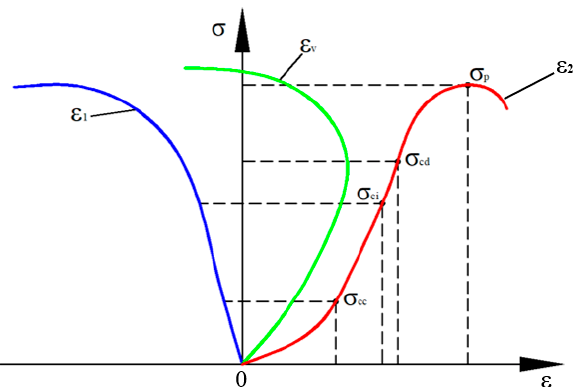
Figure 7. Diagram of characteristic stress corresponding value (Cai et al. [23]). In this paper, the closed stress σ cc , crack initiation stress σ ci , damage stress σ cd and peak strength σ p of rock specimens under different loading rates and confining pressures in triaxial tests, are obtained by using volumetric strain and circumferential strain. Figure 7 is the characteristic stress curve of the specimen. It can be seen from Figure 7 that, with the increase in confining pressure, the characteristic stress increases in varying degrees, indicating that the expansion of rock specimens will require higher stress after the confining pressure increases. From another aspect, confining pressure has an inhibitory effect on the expansion of specimens. At high confining pressure, the inflection point of the volumetric strain will be delayed, so the crack initiation stress and damage stress will be increased. It can be seen from the closed stress σ cc in Figure 8a that, under the same confining pressure, the closed stress of mudstone gradually increases with the increase in loading rate, and the closed stress has a good linear relationship with the loading rate. It is found that the closed stress and loading rate of mudstone can be described by a linear relationship: When the confining pressure W is 1 MPa, the loading rate S increases from 0.3 mm/min to 1.8 mm/min, and the closure stress increases from 12.5 MPa to 42.5 MPa, with an increase of 240%. The fitting relationship is y = 20.925 x + 6.715, and the fitting correlation coefficient between the two is as high as